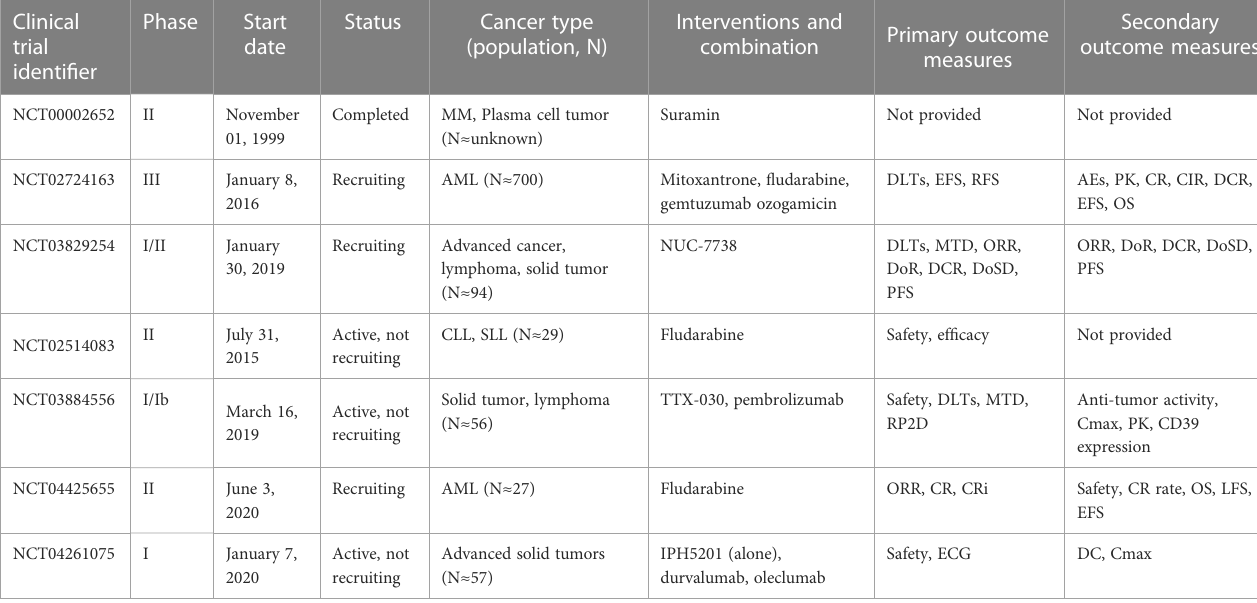
TABLE 1 Antagonists of CD39 currently in clinical trials.